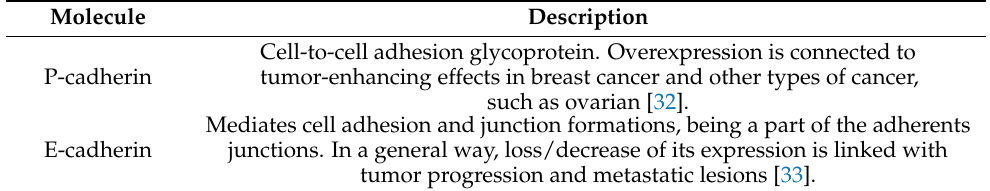
Table 3. Brief description of the P- and E-cadherin molecules. Molecule Description Cell-to-cell adhesion glycoprotein. Overexpression is connected to P-cadherin tumor-enhancing effects in breast cancer and other types of cancer,